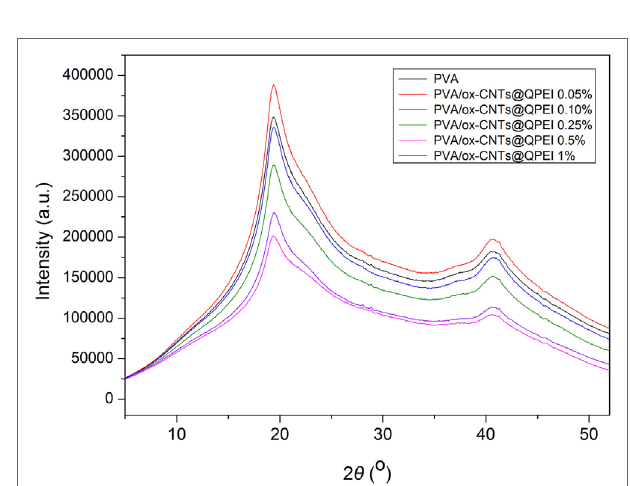
FigUre 9 | X­ray diffractograms of the functionalized poly(vinyl alcohol) nanocomposite films.